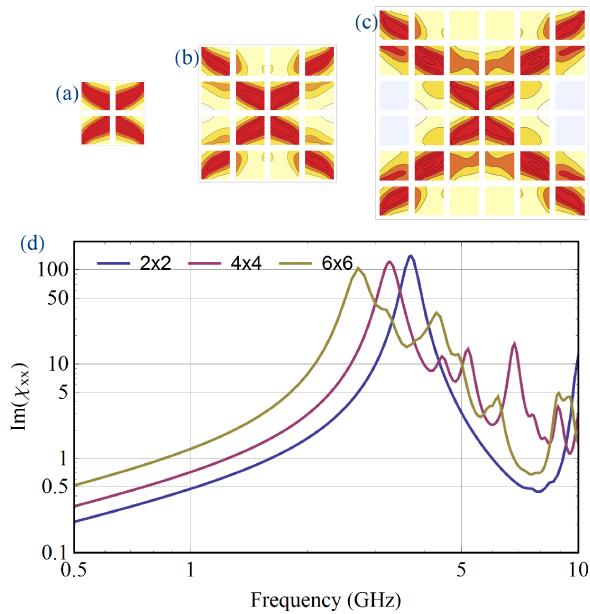
Figure 7. Ordered arrays of nanoplatelets with a macro-vortex state but no vortex core. (d) Array size dependence of the Im( χ xx ) spectrum. The interplatelet spacing is δ = 3 nm. Maps of the local susceptibility (imaginary part) associated with the low-frequency resonance for arrays of size 2 × 2 (a), 4 × 4 (b) and 6 × 6 (c). The color code is the same as in Fig.2.